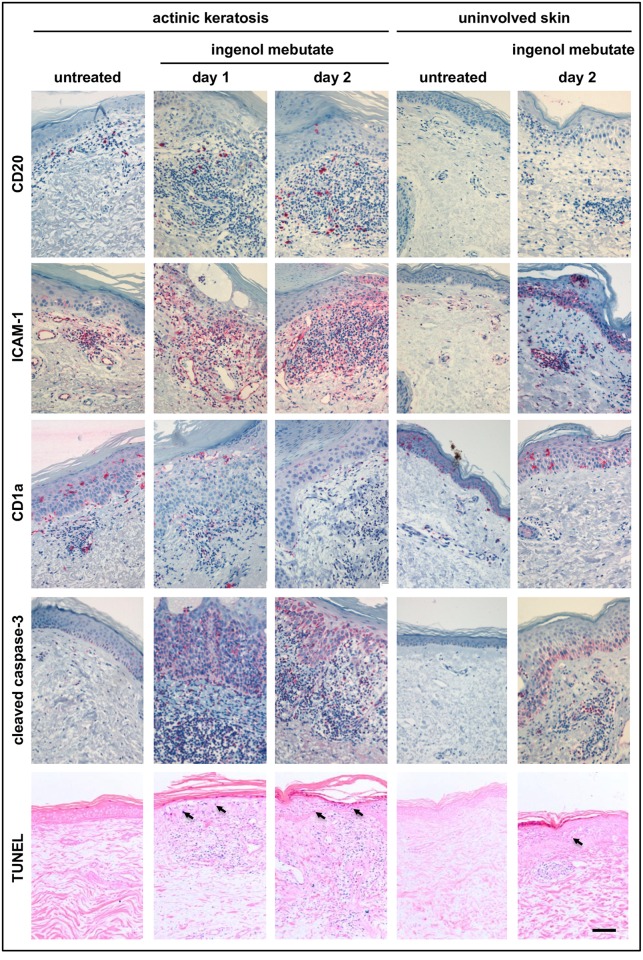
Ingenol mebutate 0.05% gel activates cutaneous blood vessels and induces epidermal cell death.Biopsy specimens from both treatment areas of all patients (n = 26) and all time points were assessed immunohistochemically for expression of CD20+ B-lymphocytes, ICAM-1 (CD54), and CD1a+ cells. Cleaved caspase 3 and TdT-mediated dUTP-biotin nick end labeling (TUNEL) reactivity indicating apoptotic responses were detected in five of these patients (arrows indicate examples of TUNEL positive epidermal cells). The figure depicts representative slides from all stainings as indicated. The scale bar represents 100 μm.